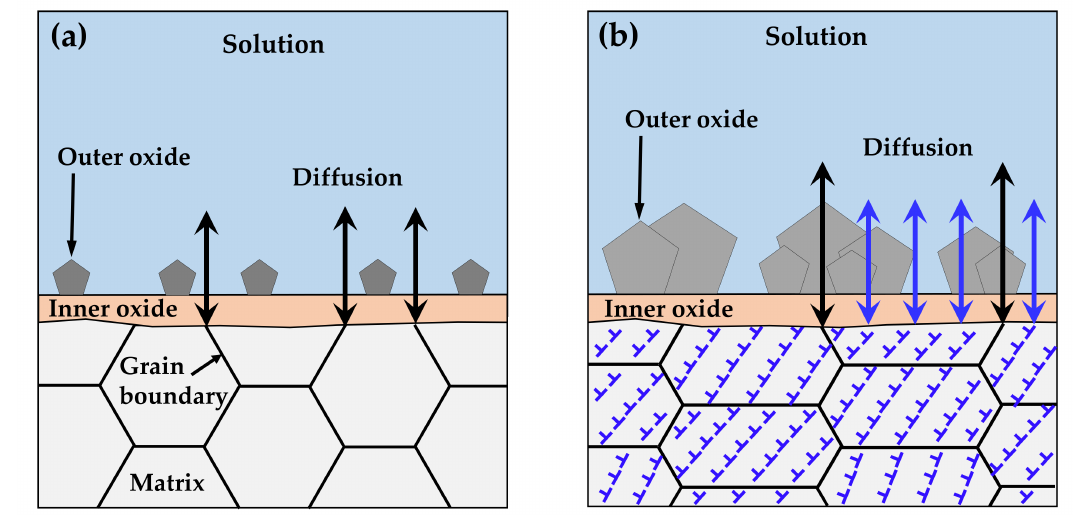
Figure 11. Accelerated corrosion of tensile-deformed Alloy 600 due to generation of diffusion paths: ( a ) before and ( b ) after